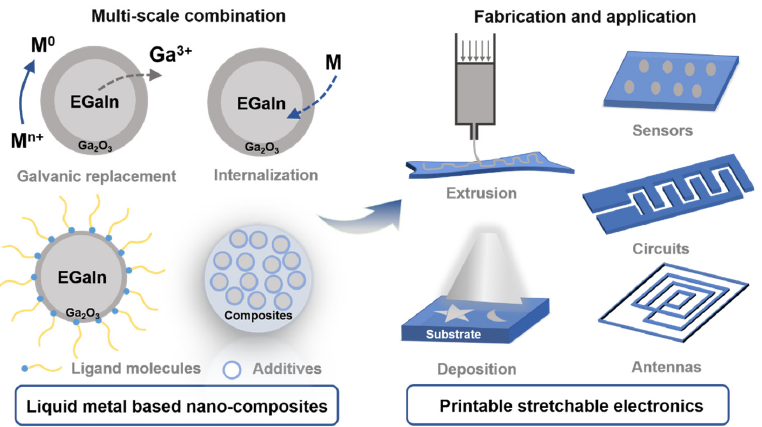
Figure 1. Schematic illustration of liquid metal-based nano-composites and the application of printable stretchable electronics.